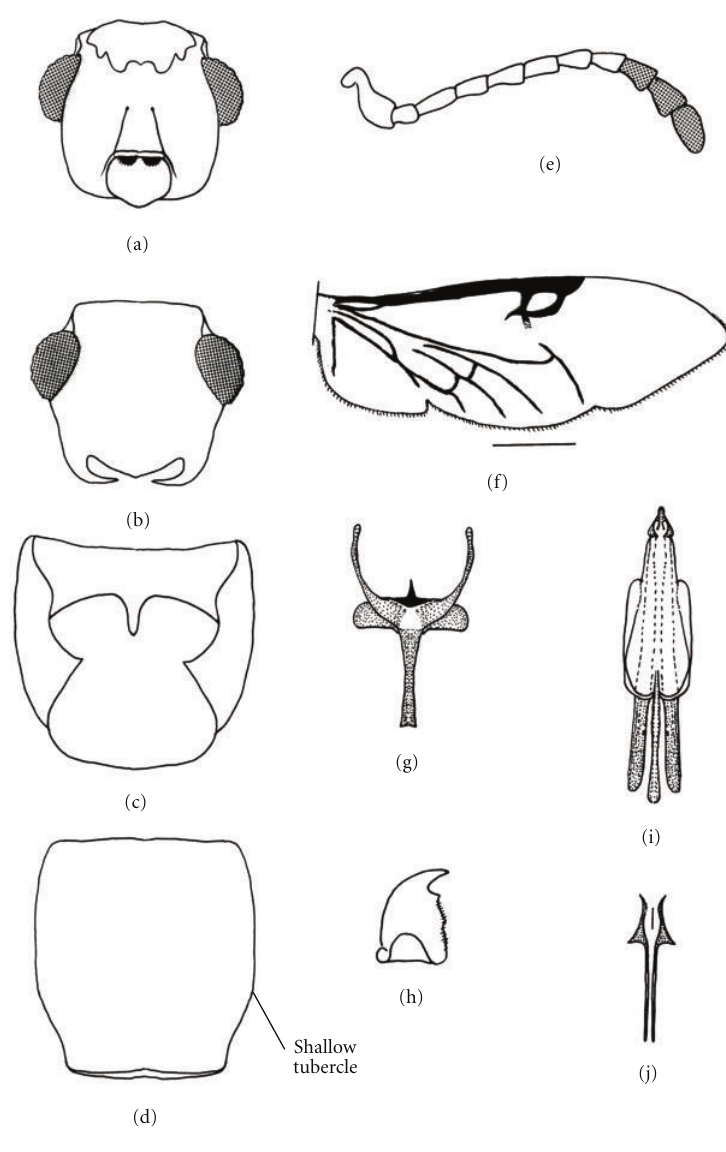
Figure 1: Various organs of Abiliella fasciata . (a, b) Head ((a) ventral, (b) dorsal). (c, d) Pronotum ((c) ventral, (d) dorsal). (e) Antenna. (f) Metathoracic wing. (g) Metendosternite. (h) Mandible. (i) Aedeagus. (j) Spiculum.